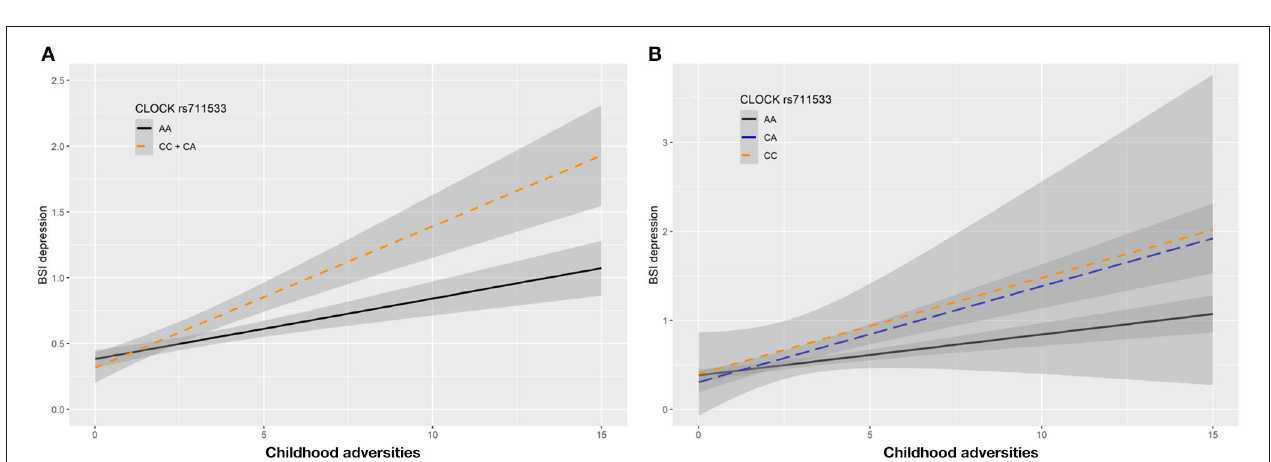
FIGURE 5 | Linear regression indicated a significant interaction between top SNP rs711533 of a clump containing 9 SNPs in the CLOCK gene and exposure to childhood adversity (CHA) on current depression symptoms (BSI-Dep) in the dominant (A) and additive (B) models, with the minor C allele being a risk allele. Linear regression indicated a significant interaction between CLOCK rs711533 genotype and childhood adverse life events (CHA) on current depression scores according to the dominant and additive models as top SNP ( p = 0.0006, FDR Q = 0.0118). Presence of the minor C allele was associated with higher depression scores in subjects exposed to more severe childhood adverse events conveying a risk effect. On the vertical axis weighted depression (BSI-Dep) scores are shown. The horizontal axis shows childhood adverse life events (CHA) as measured by an instrument derived from the CTQ (30). BSI-Brief symptom inventory. Gray shading denotes